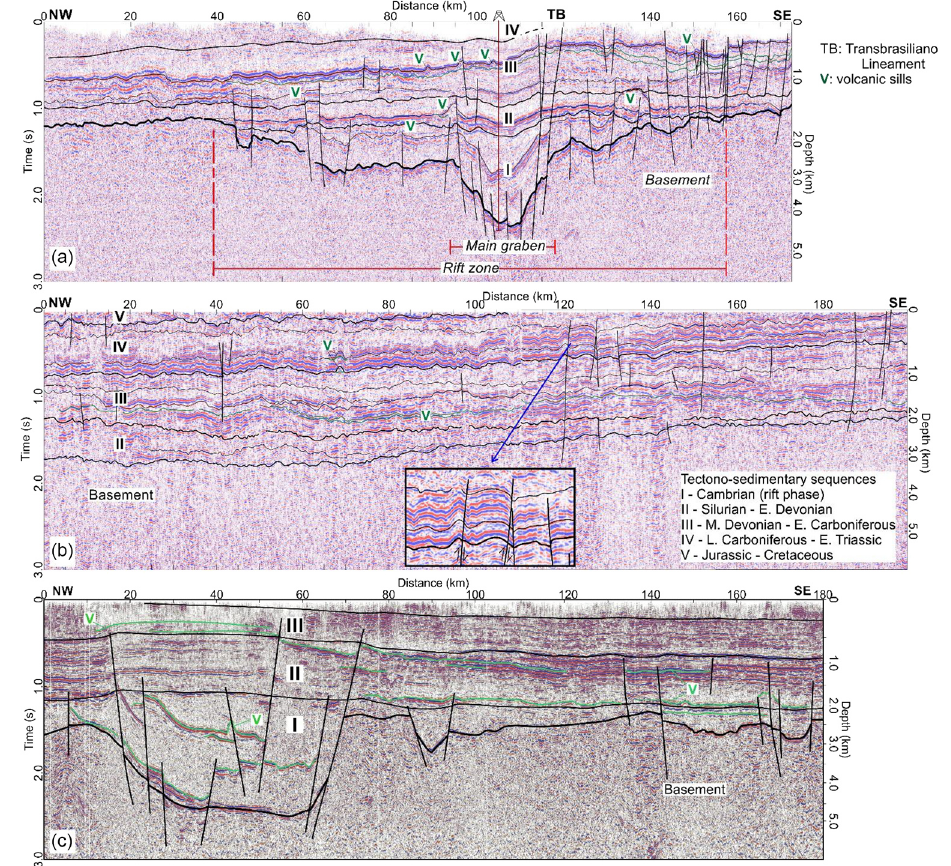
Figure 9. Seismic sections of lines L507 (a) , L304 (b) and L103 (c) , showing different structural settings within the Parnaíba basin. Inset in Line L304 shows reverse-related structures affecting Late Carboniferous to Early Triassic